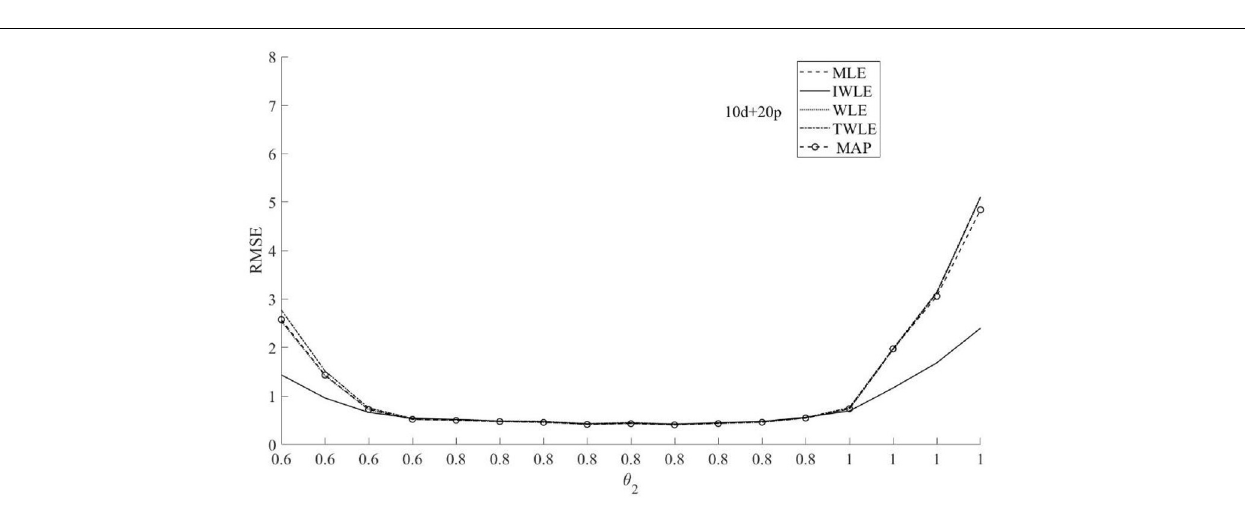
Frontiers in Psychology |